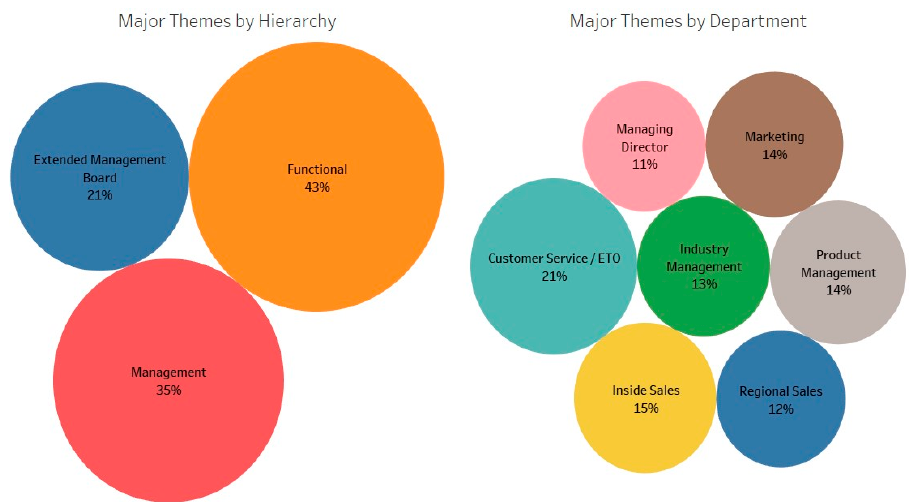
Figure 7. Major Themes’ importance by department and hierarchy, as developed for this study.